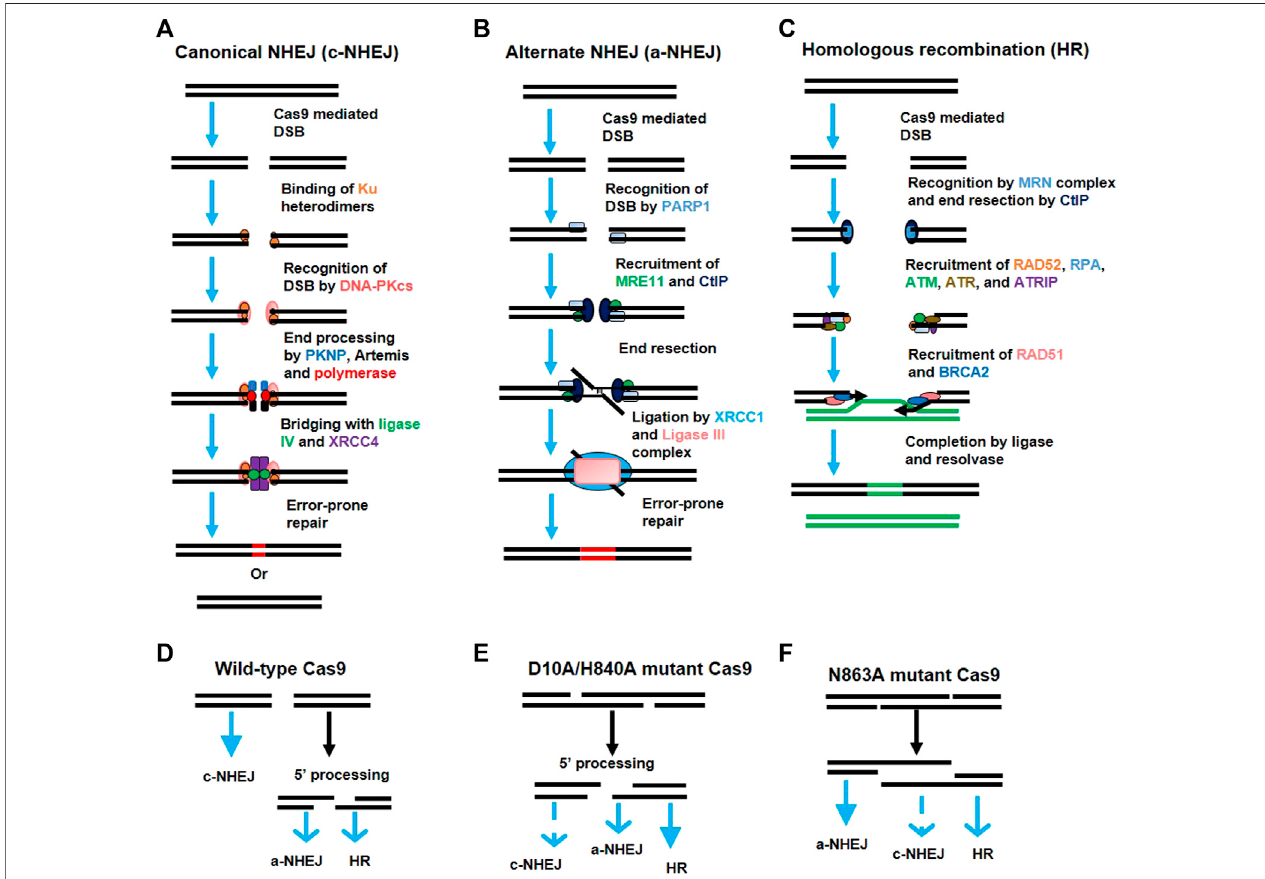
FIGURE 3 | Activation of various DNA repair pathways after generation of double-strand breaks (DSBs) by Cas9. (A) The canonical non-homologous end joining (c-NHEJ) pathway. Broken DNA ends are recognized by the Ku heterodimer (Ku70 and Ku80), which recruits the DNA-PK catalytic subunit (DNA-PKcs). DNA-PKcs recruits various proteins like PKNP, Artemis, and polymerase for end processing. The ends are rejoined by ligase IV and XRCC4 with error-prone repair. (B) Alternate non-homologous end joining (a-NHEJ) pathway. The DSBs are recognized by the PARP1 protein which recruits MRE11 and CtlP for end resection. The internal microhomologies are associated with the larger deletions at junctions than that of c-NHEJ. Ligase III and XRCC1 ligate the strand ends. (C) The homologous recombination (HR) pathway. The DSBs are recognized by the MRE11-RAD50-NBS1 (MRN) complex which activates the DNA damage response via ATM kinase. The single-strandDNA(ssDNA)isformedafter5 ′ to3 ′ endresectionbyCtlPwhichallowsRAD52andDNAreplicationproteinA(RPA)torecognizetheexposedssDNA.This activates the Ataxia Telangiectasia and Rad3-related protein (ATR) to assist in HR repair. The RPA-coated ssDNA is replaced by the BRCA2 and RAD51 protein which performs strand invasion via searching for the homologous sequence. The junction is resolved and the ends are joined via resolvase and ligase. (D – F) Choice of DNA- repair pathway after DSBs. The predominance of a particular DNA-repair pathway (bold blue arrow) depends upon the type of lesion generated by a particular variant of Cas9.